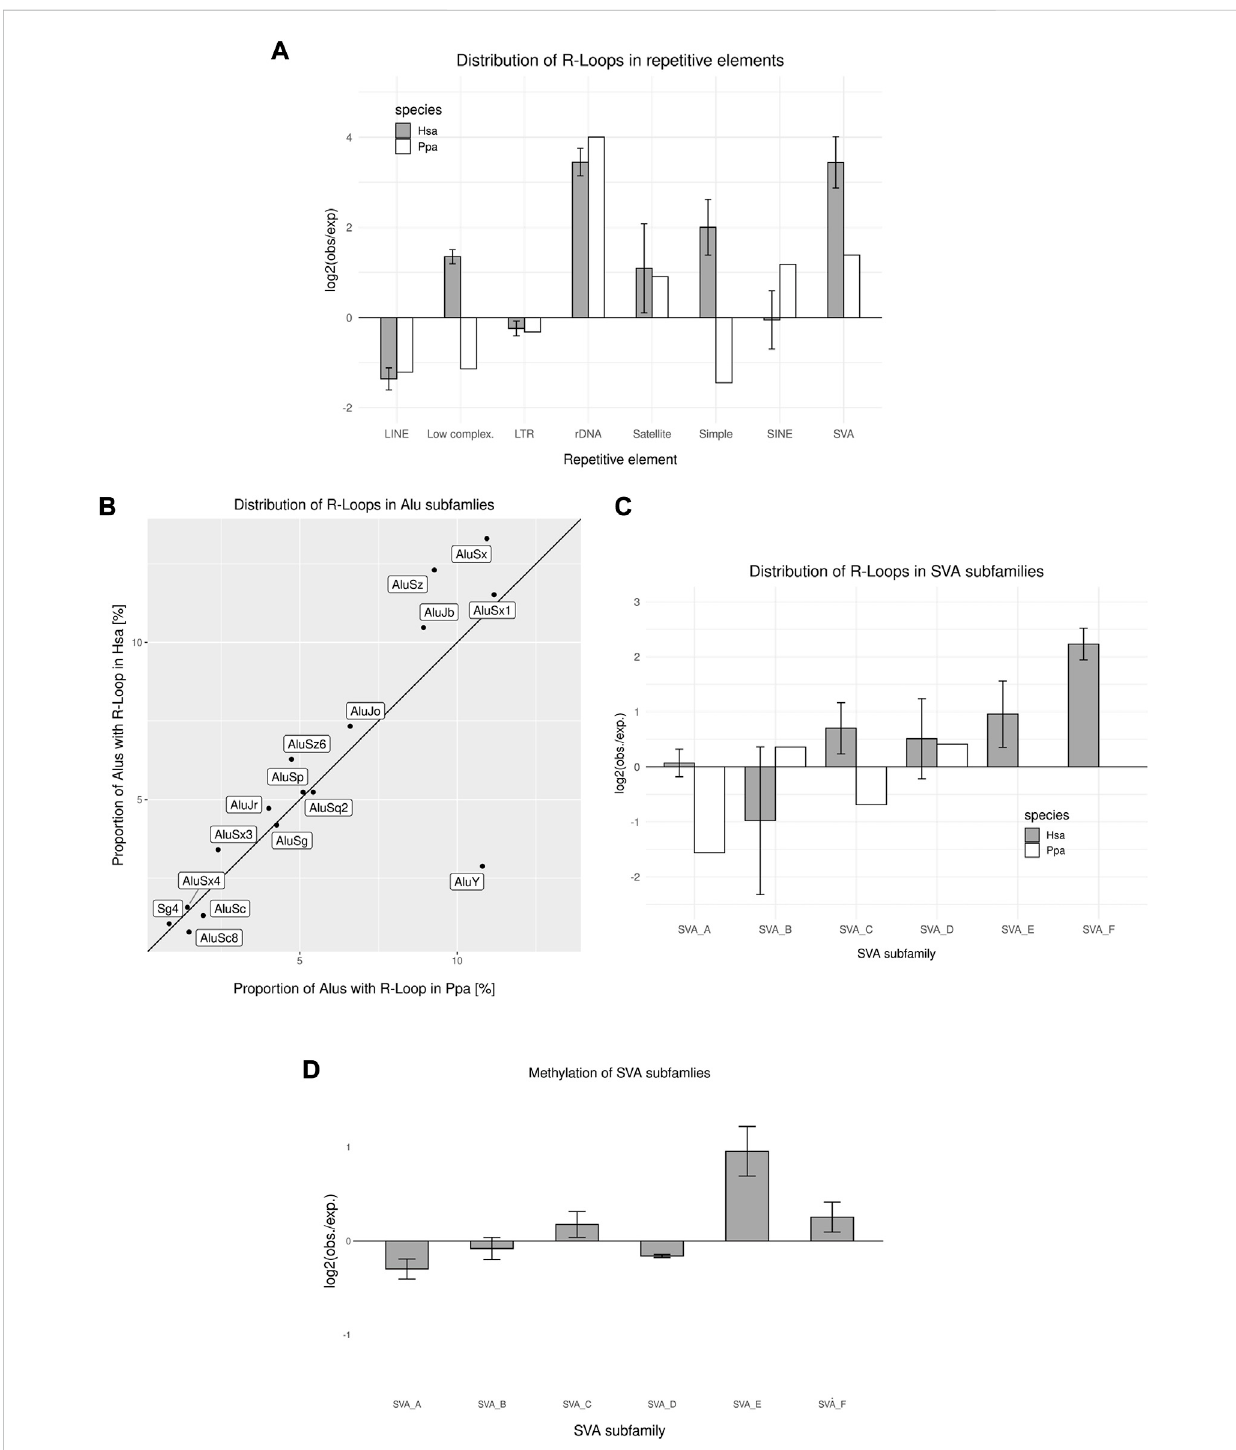
FIGURE 4 R-loop Distribution across transposable elements. (A) Genomic distribution of R-loop peaks across repetitive elements compared to the expected genomic distribution in human and bonobo sperm. (B) Distribution of R-loops in different ALU subfamilies in human and bonobo sperm. The bisection indicates an equal distributionbetween human and bonobo (C) Distribution of R-loop peaks inSVA subfamiliescompared to the expected distribution in human and bonobo sperm. (D) Relative methylation rate of SVA subfamilies. Data in (A), (C) and (D) represent mean ± SEM among the biological